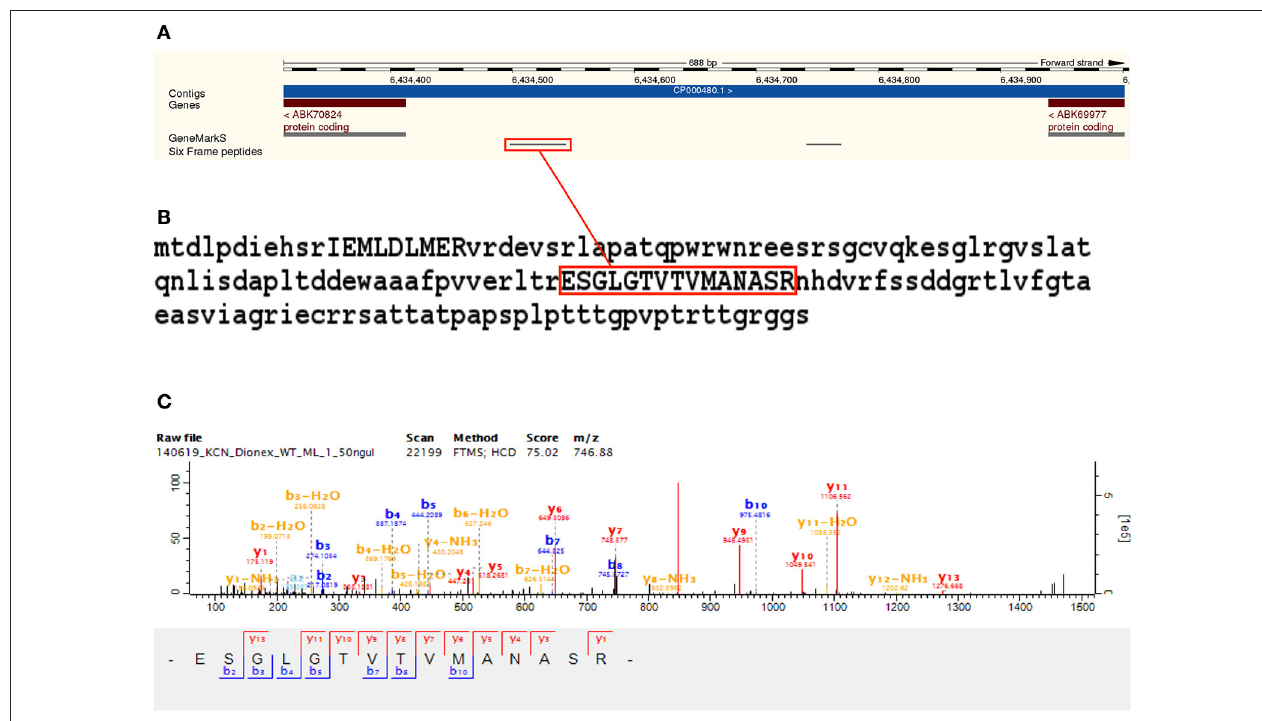
FIGURE 7 | Novel ORF identification. Panel (A) shows the identification of two peptides from eight MS/MS spectra mapping to an intergenic region in M. smegmatis mc 2 155 from position 6,434,313 to 6,434,801 on the reverse strand. Panel (B) shows the identified sequence, extended up to the next upstream start codon, with identified peptides in uppercase. The sequence yielded a protein nr BLAST alignment to G7CE94 (Lipoprotein LppV), a 182 amino acids long predicted protein annotated to M. thermoresistibile , with an E -value of 2.13747e-44. Panel (C) shows a representative MS/MS spectrum identified with the translated six frame database.